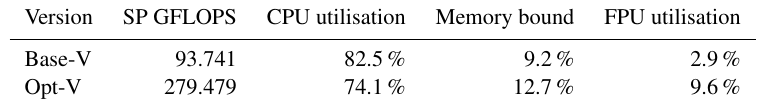
Table 1. General indicators detected by the VTune HPC performance detection tool for the two versions of